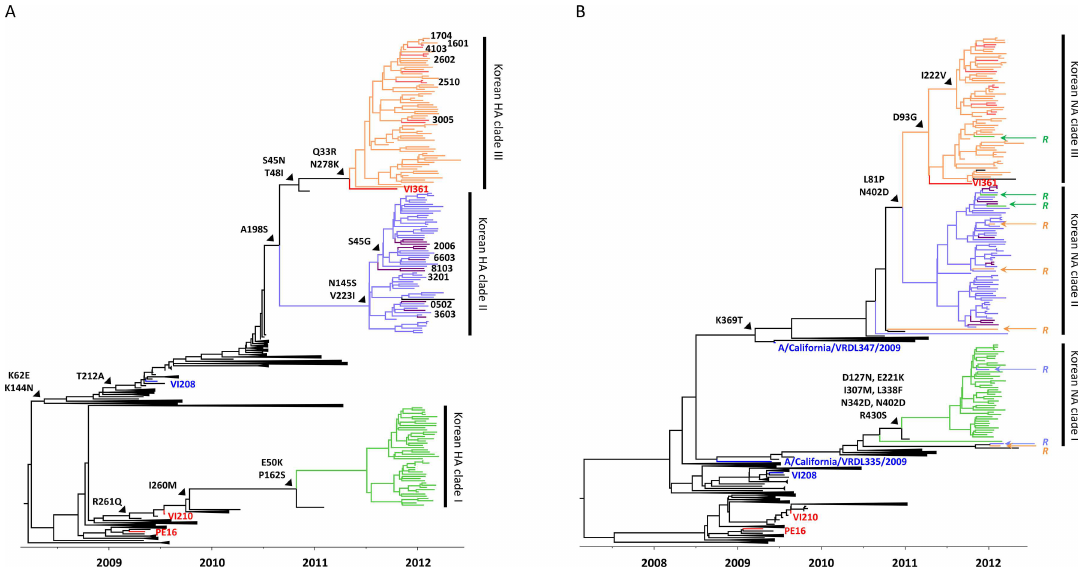
Fig 2. Phylogenetic relationships of the HA and NA genes of Korean H3N2 strains circulating in the 2011/12season. The evolutionary relationships of the HA and NA genesof Korean H3N2 strains were reconstructed using the KISED (n = 154) and KUMC (n = 21) sequences.The sequencesdownloaded from the NCBI (n = 451) and GISAID (n = 8) databases were used as references. The three Korean HA and NA clades are indicatedwith different colors (clade I, light green; clade II, violet; and clade III, orange),and the KUMC sequencesin the clades II and III were highlightedwith purpleand light red colors, respectively.The vaccine virus tips (PE16, VI210, and VI361) and the other clade-defining sequences(VI208, A/ California/VRDL335/2009, and A/California/VRDL347/2009) were colored with red and blue, respectively. The KUMC viruses used for the HI assay were indicatedwith viral isolatenumbers(please see Table 1). In the NA tree, the sequencesof reassortment candidate strains betweenthe HA and NA genes were indicatedwith a capitalletter ‘ R ’ and the colors of their corresponding HA clades. Trunk lineageamino acid mutationswere also indicated.